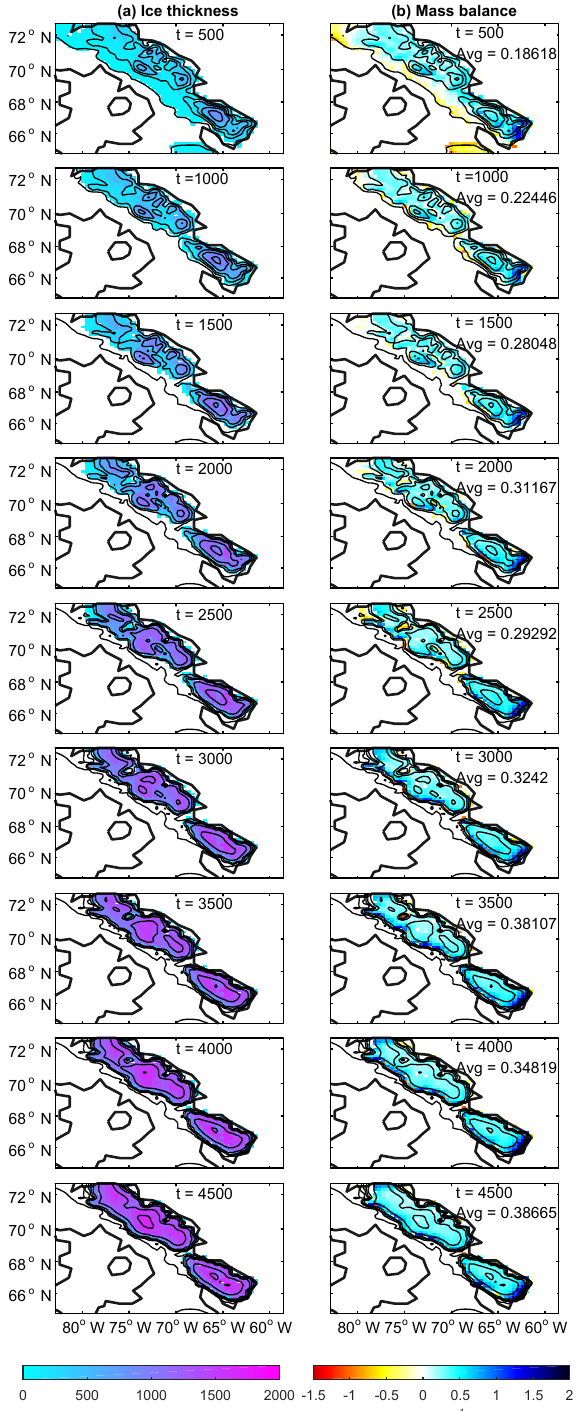
Figure 2. Ice growth due to WRF–ice model iterations: (a) the ice thickness from the ice sheet model and (b) the mass balance from WRF. The average mass balance over ice-covered areas for each iteration is included in the right column.